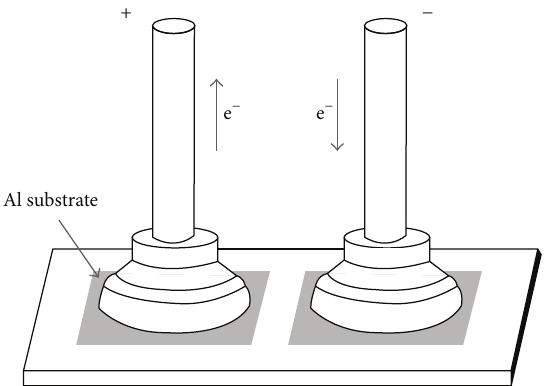
Figure 1: Electrical mechanism diagram of wire bonding interface device.